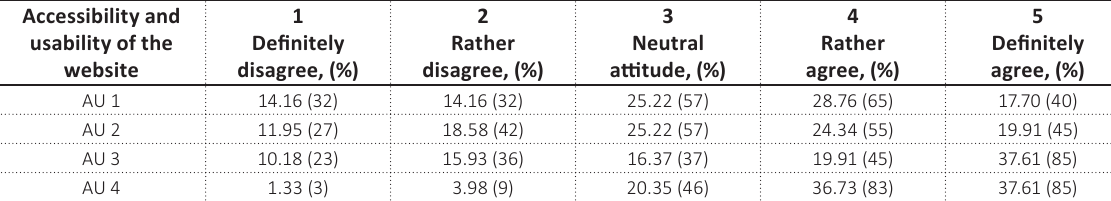
Table 4. Perceived usefulness factor